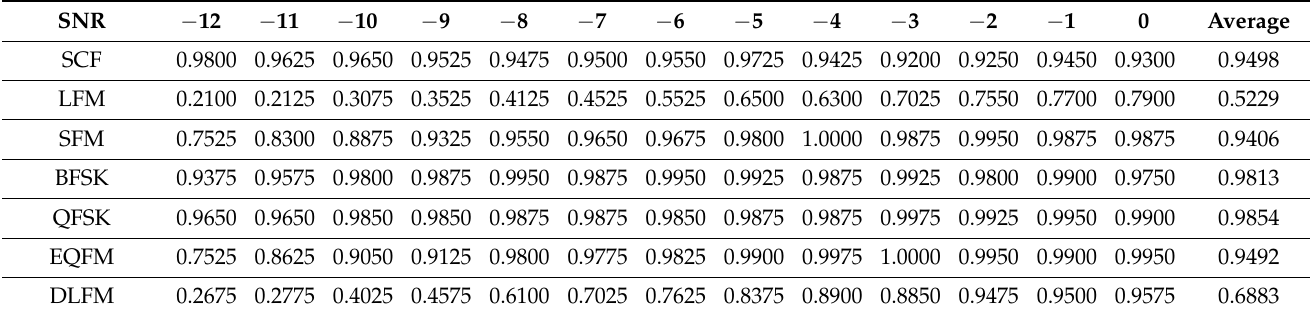
Table A22. Semi-supervised classification results with the datasets in Situation Dataset 4 ( d = 0.5